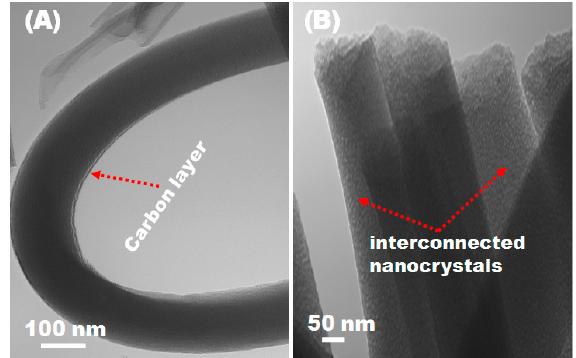
Figure 3. ( A , B ) TEM images of hierarchical mesoporousC/NiCo 2 O 4 hybrid nanofibers show the surface morphology.